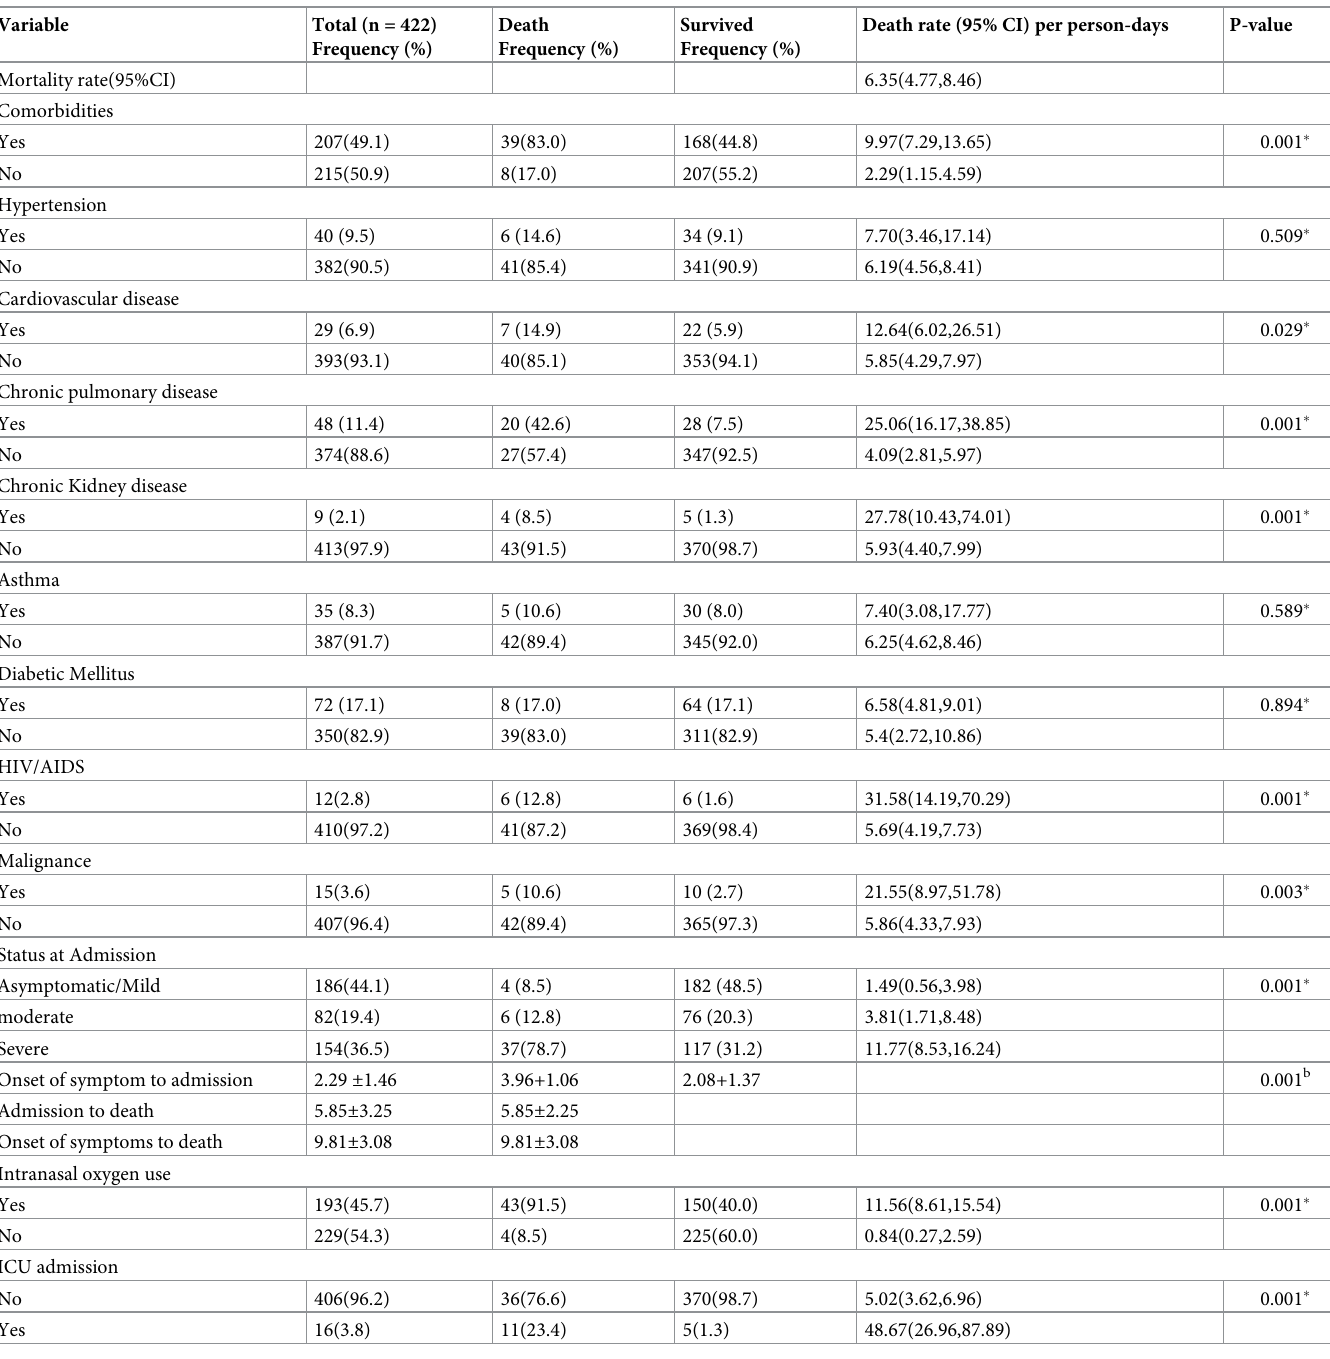
Table 2. Clinical characteristics of patients and treatment outcome status of hospitalized with COVID-19 to Bokoji Hospital treatment centre,